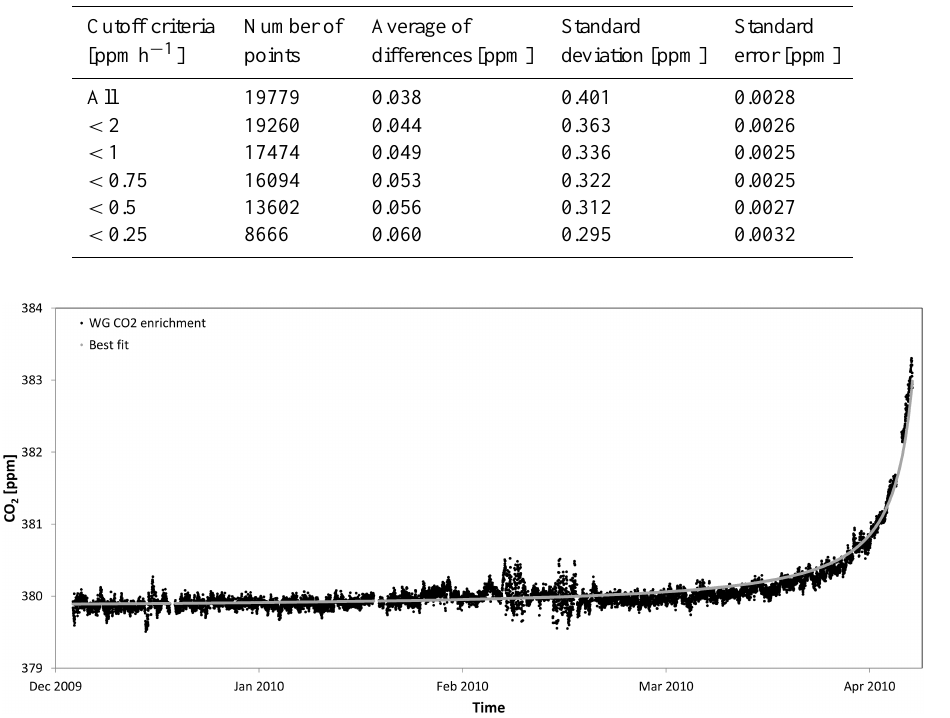
Figure 6. The CO 2 values of the calibration gas cylinder B23 calculated by using only the low and the high span cylinders against time (black points) and the calculated best fit function according to Langmuir (grey points) with a = 5715797 and b = 568897. The CO 2 values increase with time (corresponding to decreasing pressure). The best fit function was used to correct the measured working gas CO 2 values of the NDIR